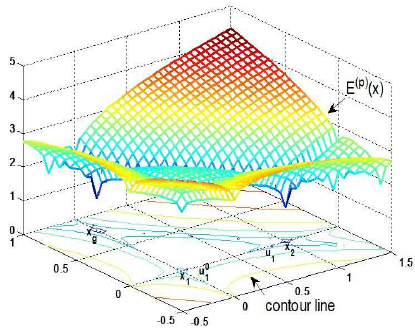
Figure 2. Three attraction basins of the objective function correspond to three energy levels in 3-D space.